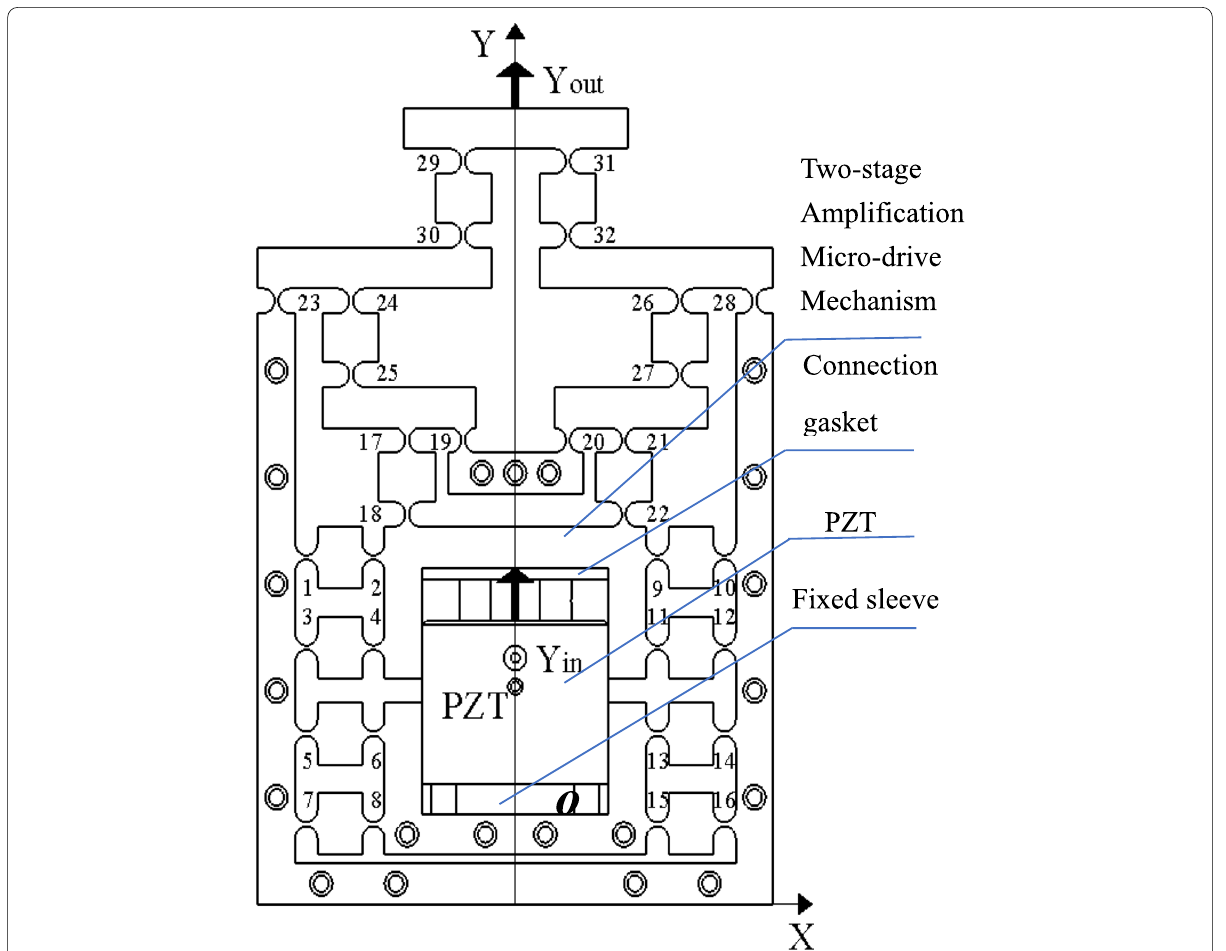
Fig. 1 Schematic diagram of working principle of micro-drive